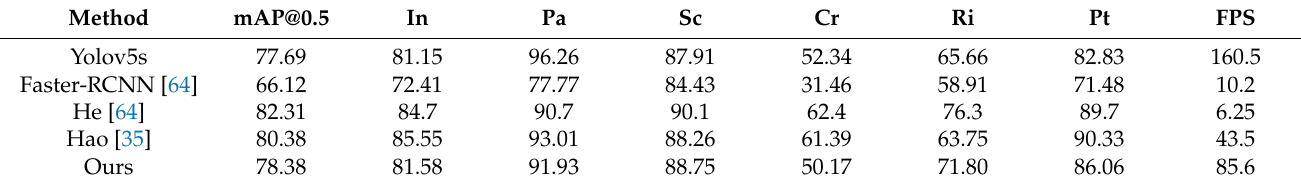
Table 6. Quantitative Comparisons of Different Detection